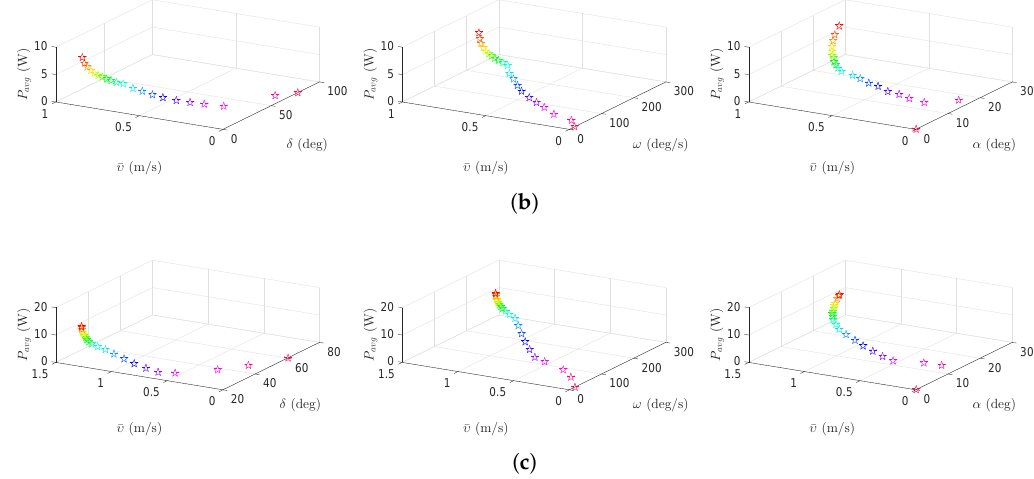
Figure 11. Optimal gait parameters for the lateral undulation motion pattern for the land-based snake robot: ( a ) 3D plots of optimal gait parameters for robot with n = 5 links; ( b ) 3D plots of optimal gait parameters for robot with n = 10 links; and ( c ) 3D plots of optimal gait parameters for robot with n = 20 links. Colors illustrate different weights of the objective